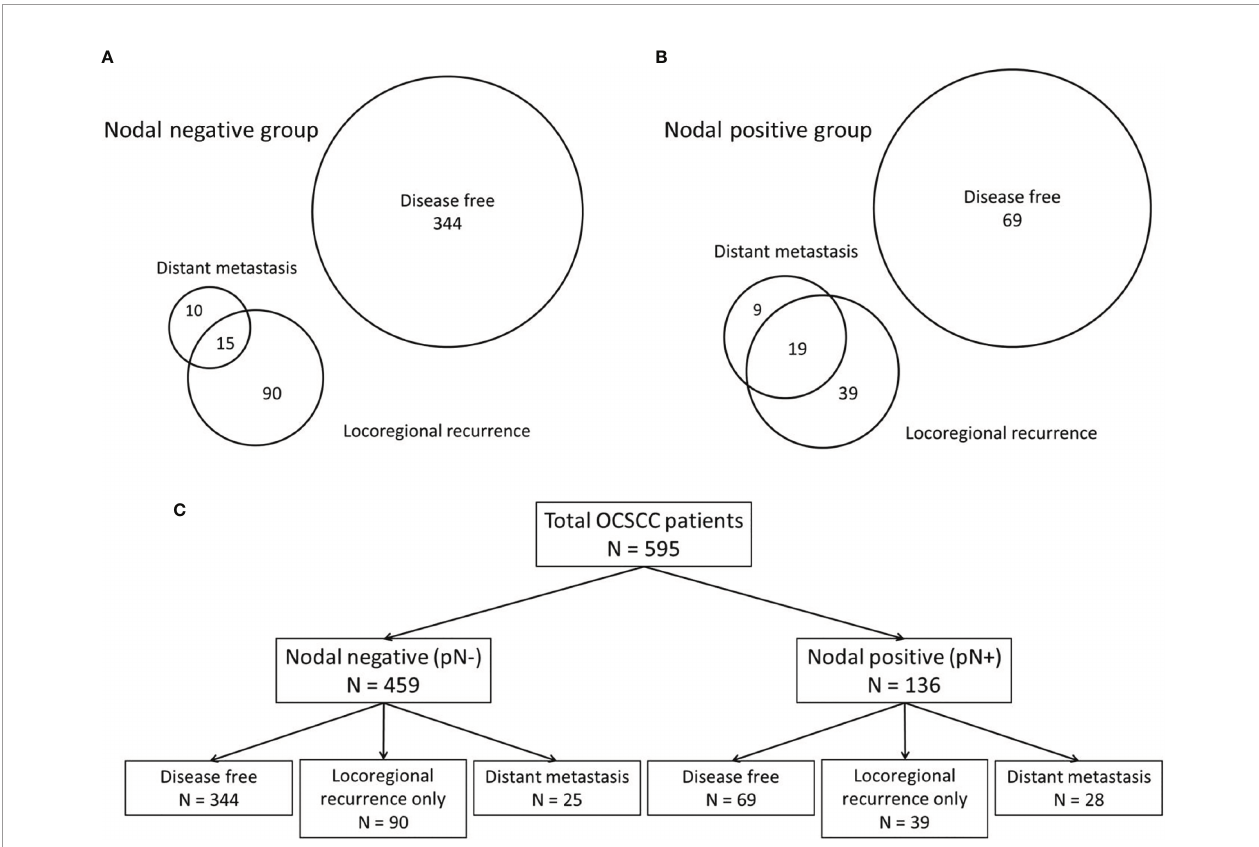
FIGURE 1 | The patients were classi fi ed according to their patterns of disease progression. According to the patterns of disease progression, the patients were classi fi ed into those with disease-free development (without disease progression), locoregional recurrence only, and distant metastasis with any locoregional status. (A) Venn diagram of the nodal-negative group. (B) Venn diagram of the nodal-positive group. (C) The classi fi cations of both the nodal-negative and -positive groups according to the patterns of disease